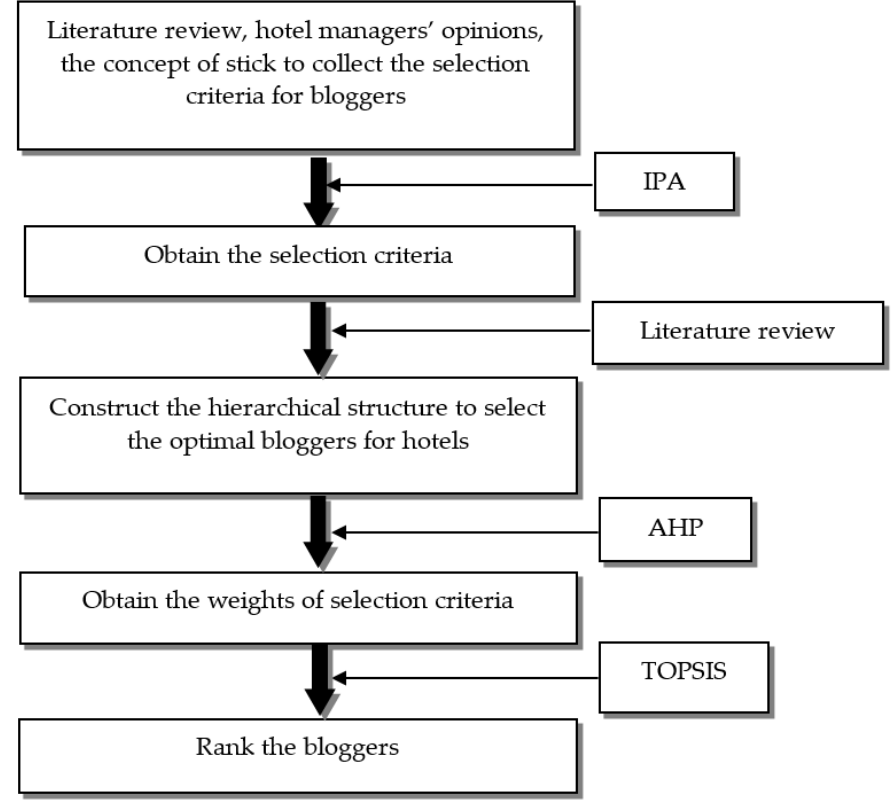
Figure 1. Steps of the selection procedure for bloggers.